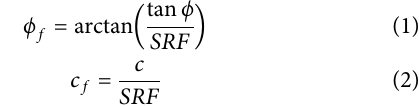
Frontiers in Physics |